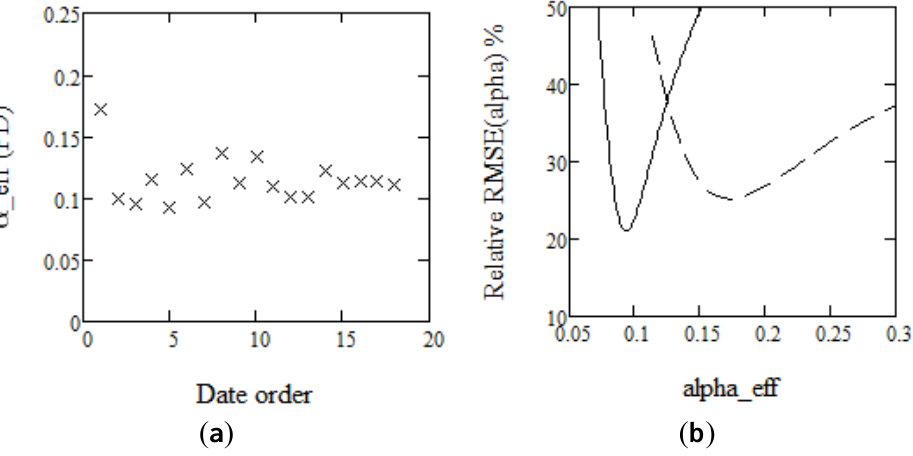
Figure 11. ( a ) Estimates of  ( b ) sensitivity of the relative RMSE using PD to  (dashed line, 2011-06-04) and lowest (solid line, 2012-01-28) 